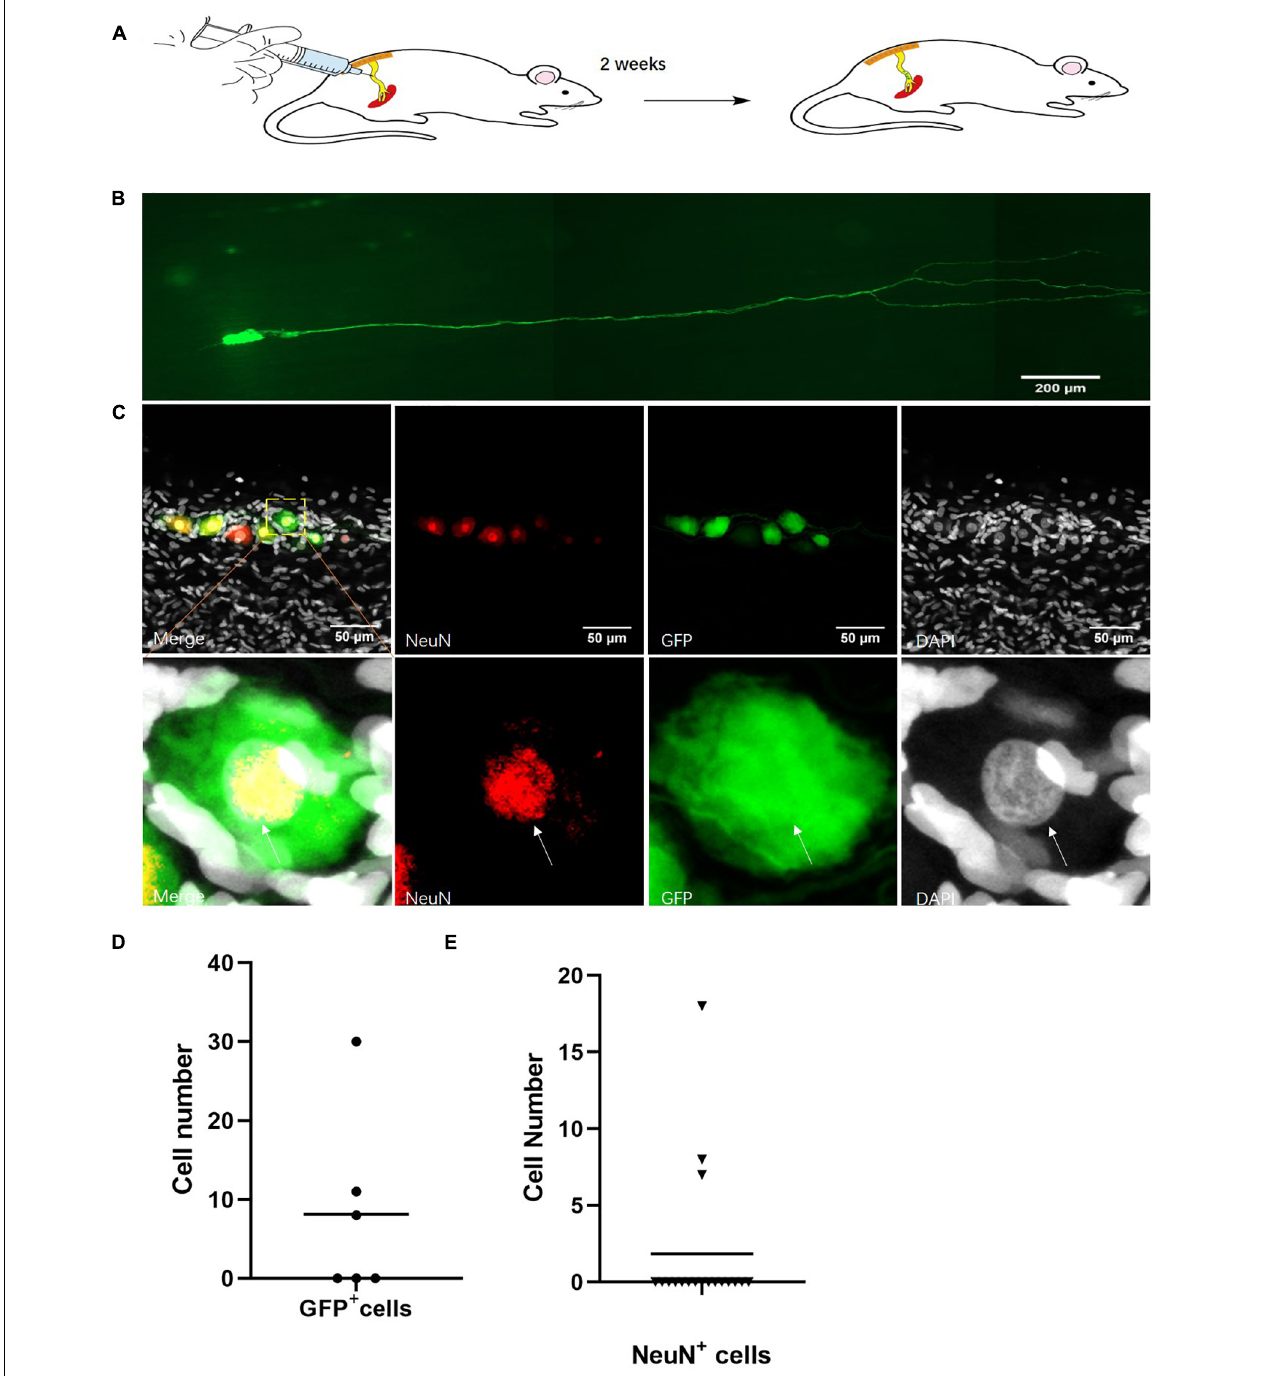
FIGURE 2 | Identification of neurons in the sciatic nerves of adult rats. (A) Sciatic nerve infection model. hSYN -promoter GFP AAV2/9 virus was injected into the rat sciatic nerves for 2 weeks. n = 12. (B) Neuronal cells marked by GFP in vivo . Cells expressing GFP (green) in the sciatic nerves of adult rats. n = 6 (sciatic nerve with GFP marked neuronal cells). Scale bar, 200 µ m. (C) The quantification of GFP + cell number in sciatic nerves of virus infected rats. hSYN -promoter GFP AAV 2/9 virus was injected into the sciatic nerves. The circle points represented the cell number of GFP + cells in the virus-infected sciatic nerve ( n = 6 of 12 which contain the GFP + cells). (D) Neurons labeled by AAV2/9 virus in sciatic nerves of adult rats in vivo . Two weeks after injection of hSYN -promoter GFP AAV2/9 virus, immunofluorescence staining for NeuN (red) and DAPI (gray) in GFP (green)-labeled cells in the sciatic nerves. n = 18 (total sciatic nerves with GFP + neuronal cells), n = 3 (sciatic nerves with NeuN marked GF P + neuronal cells). Scale bar, 50 µ m. (E) The quantification of NeuN + cells number in the sciatic nerve of virus injected rats. The sciatic nerves of those rats are infected by hSYN -promoter GFP AAV2/9 virus ( n = 18). The triangular points represent the cell number of NeuN + cells in a sciatic nerve with GFP + cells ( n = 3). The white arrow points to the positive cells.